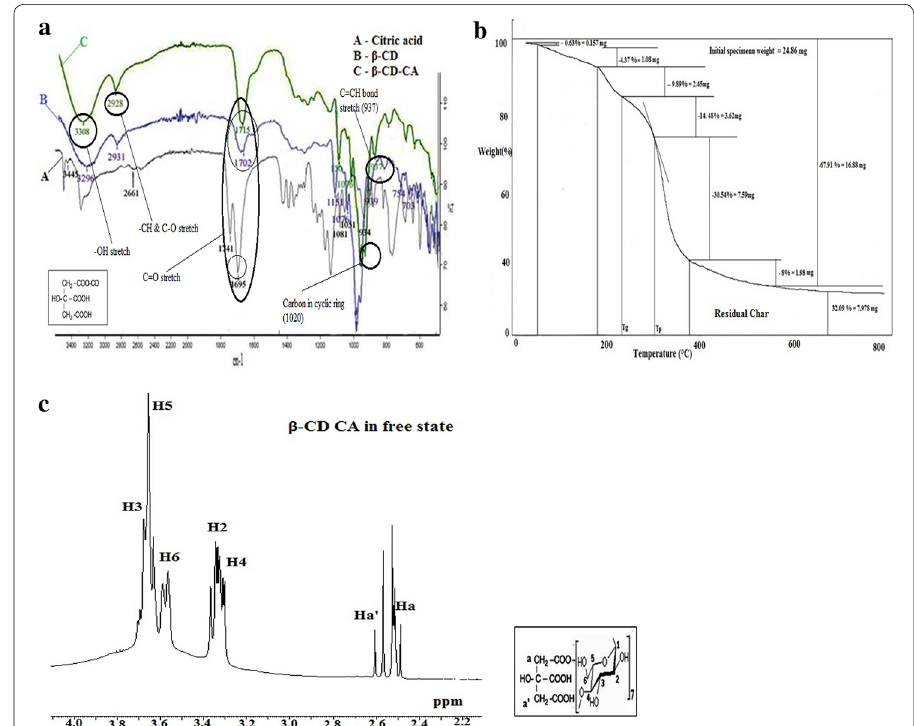
Fig. 1 a Comparative FTIR of citric acid, β-CD and β-CD CA b TGA of β-CD CA c 1 H-NMR of β-CD